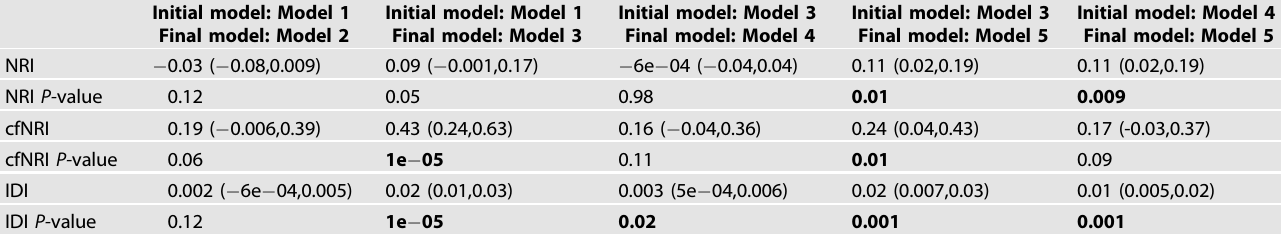
Fig. 4 Evaluation of the predictive ability of the constructed predictive model using AUC. AUC area under the receiver operating characteristic curve, GRS genetic-risk score. Table 1. Statistics for model improvement with the addition of genetic and non-genetic-risk factors for